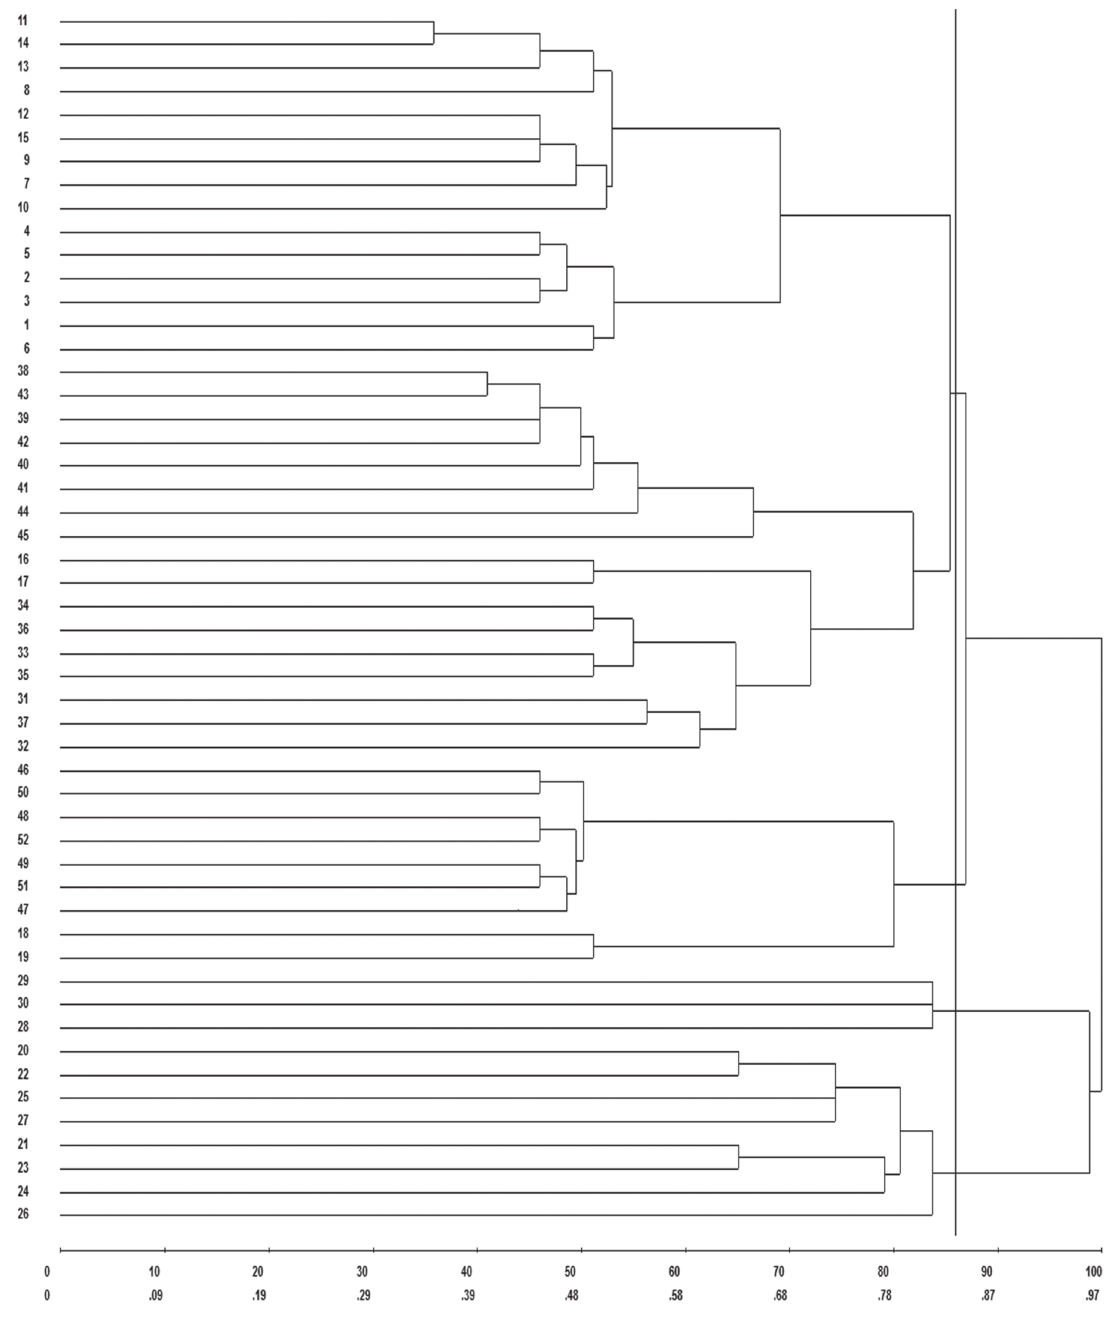
Figure 5 - Dendrogram obtained by cluster analysis using the mean Euclidean distance and the UPGMA method for the evaluation of the total production of honey. Set of 20 variables in 52 honey samples of A. mellifera in the counties of Marechal Cândido Rondon and Santa